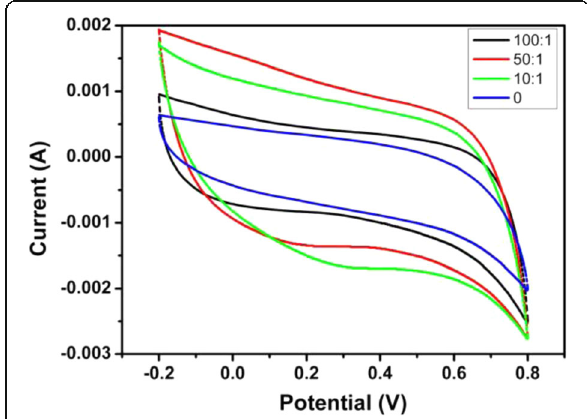
Fig. 5 Cycle voltammetry curves of ERGO and ERGO/CNTs with a different GO/CNTs mass ratio at 50 mV/s. (All films were prepared by CV at a scan rate of 50 mV/s)